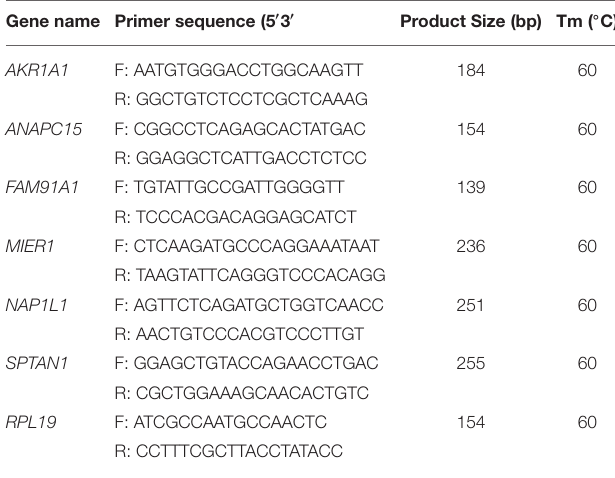
TABLE 1 | The primers of the mRNAs for